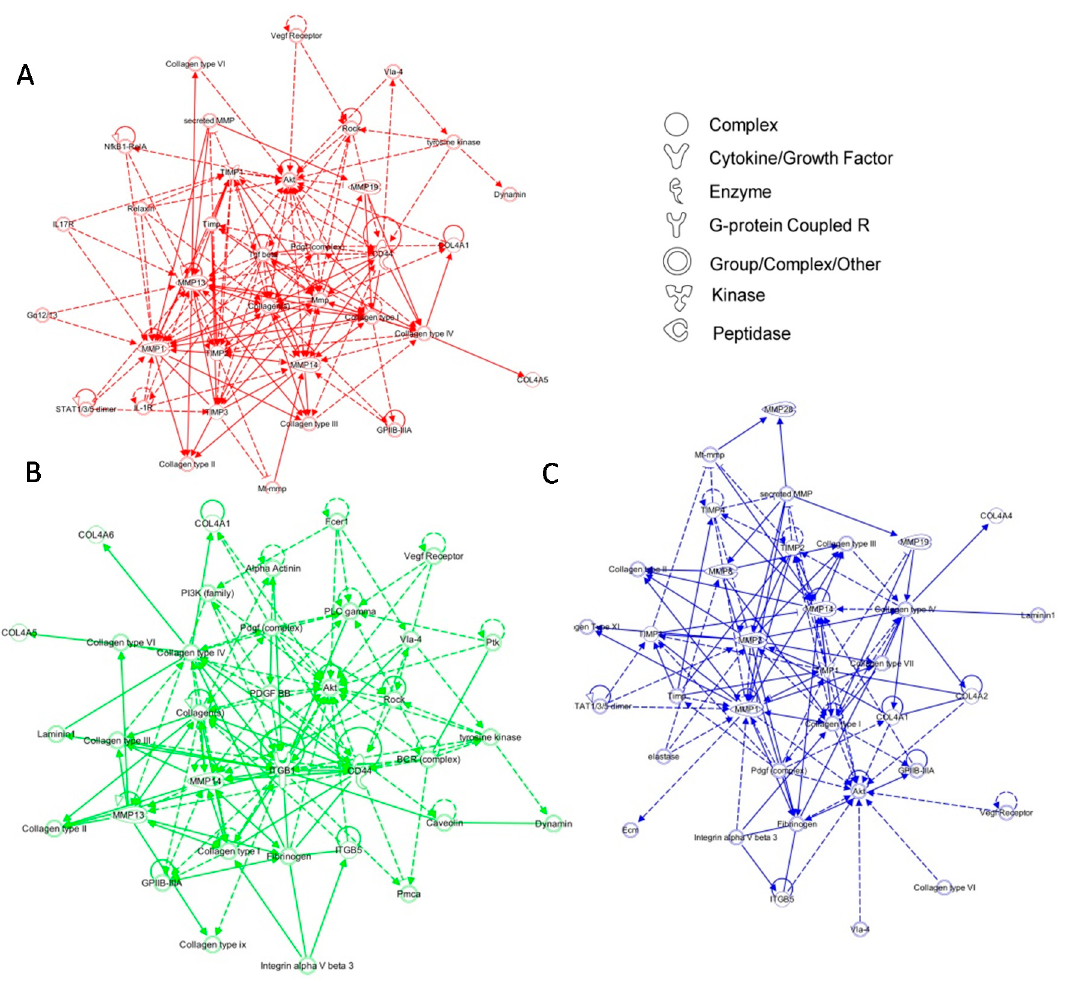
Figure 4. Network analysis of keratinocyte subpopulations. Top scoring Ingenuity Pathway Analysis (IPA)-constructed transcriptome networks based genes that were significantly up-regulated in cluster 1 ( A ; red), cluster 2 ( B ; green), and cluster 3 ( C ; blue). Direct relationships are indicated by solid lines, and dashed lines represent indirect relationships.